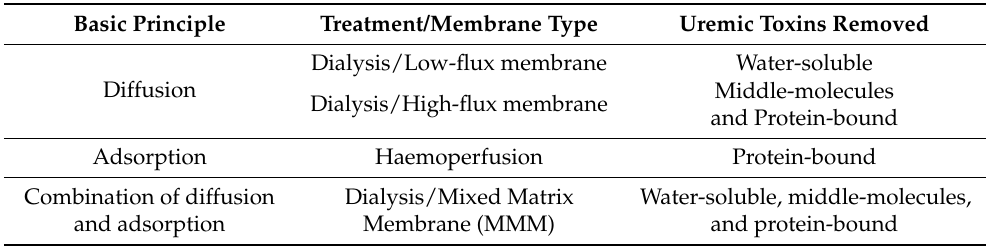
Table 2. Types of dialysis treatment based on the principle and their capability to remove the uremic